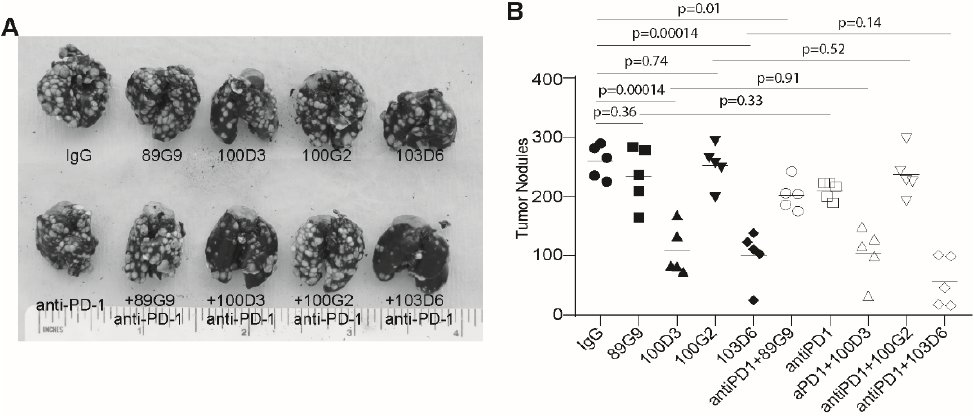
Figure 7. OPN blockade immunotherapy suppresses colon tumor growth in vivo. ( A ) CT26 cells were injected i.v. into tail veins of BALB/c mice. Three days later, IgG and the indicated OPN mAbs (200 µ g/mouse) were injected to the tumor-bearing mice s.c. either alone or in combination with anti-PD-1 (200 µ g/mouse) ( n = 5) every 3 days. ( B ) Mice were sacrificed on day 14 and analyzed for lung tumor nodules. Shown are representative tumor-bearing lungs of each treatment group (top panel). The tumor nodule number was quantified and presented at the bottom panel.